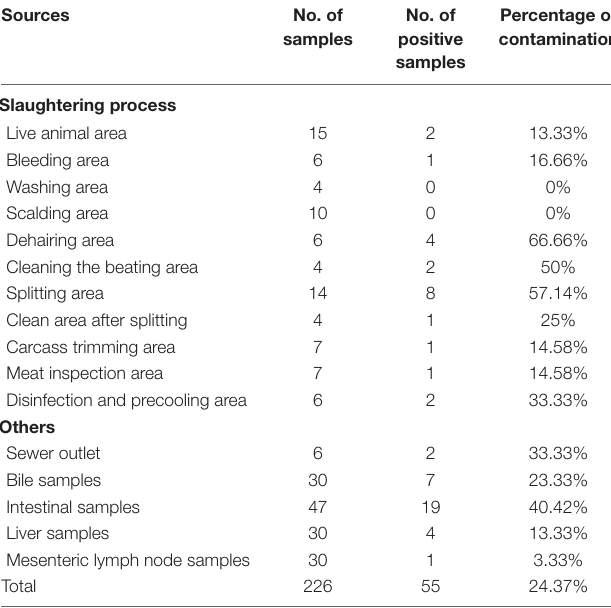
TABLE 1 | Sampling design and prevalence of Salmonella from different sources. TABLE 2 | Distribution of the studied Salmonella isolates according to sampling